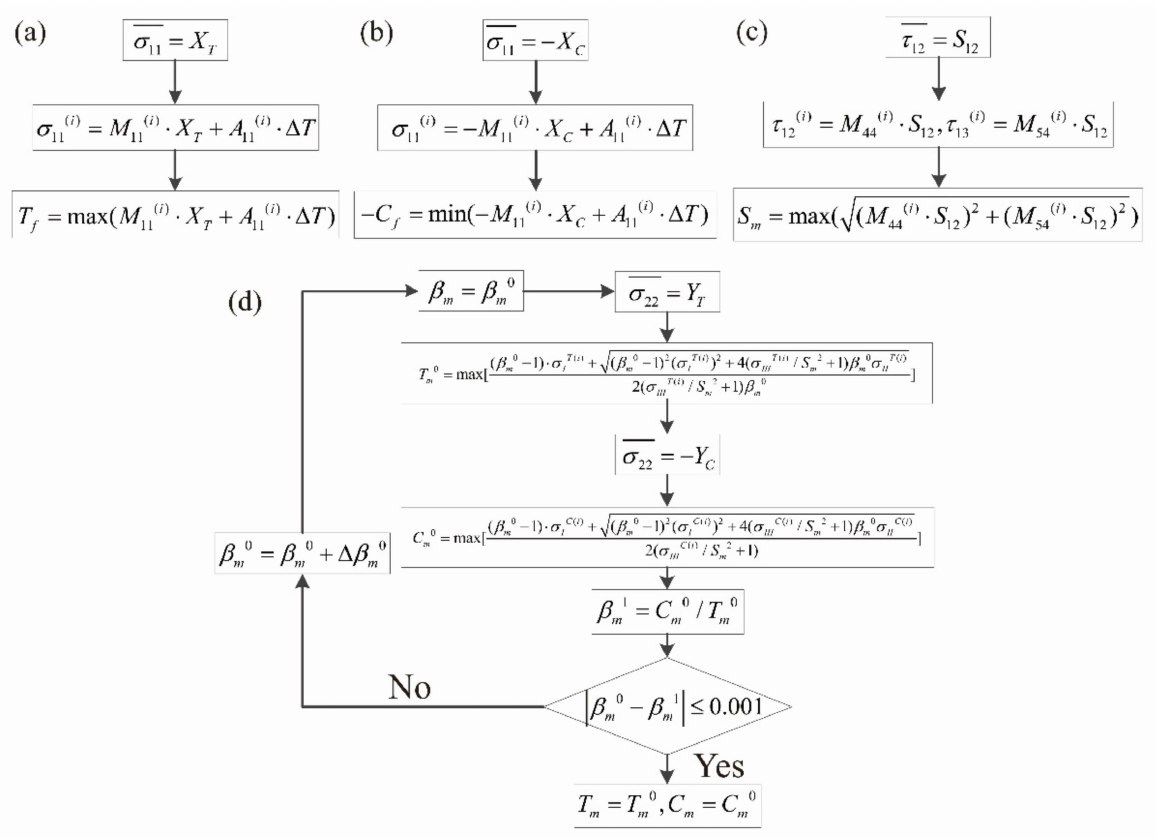
Figure 7. With the macro-scale strengths shown in Table 3, the micro-scale strengths of the